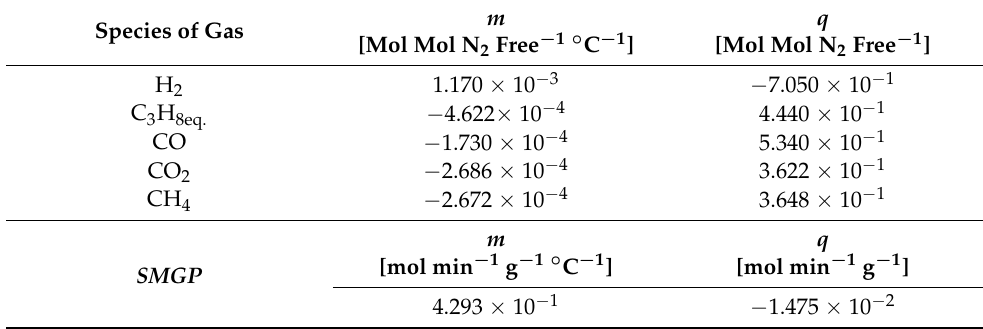
Figure 3. Experimental results from devolatilization peaks for WSP pellets as functions of temperature (points), with regression straight lines (dotted): ( a ) molar fractions on N 2 free-basis of produced gases at devolatilization peaks ( 𝑌 𝑖,𝑜𝑢𝑡𝑝 Equation (5)); ( b ) SMGP (Equation (6)). Table 3. Slopes ( m , Equation (7)) and y-axis intercepts ( q , Equation (7)) of the regression straight lines of 𝑌 𝑖,𝑜𝑢𝑡𝑝 (Equation (5), i = H 2 , CO, CO 2 , CH 4 , and C 3 H 8,eq. ) and SMGP (Equation (6)), for WSP pellets.